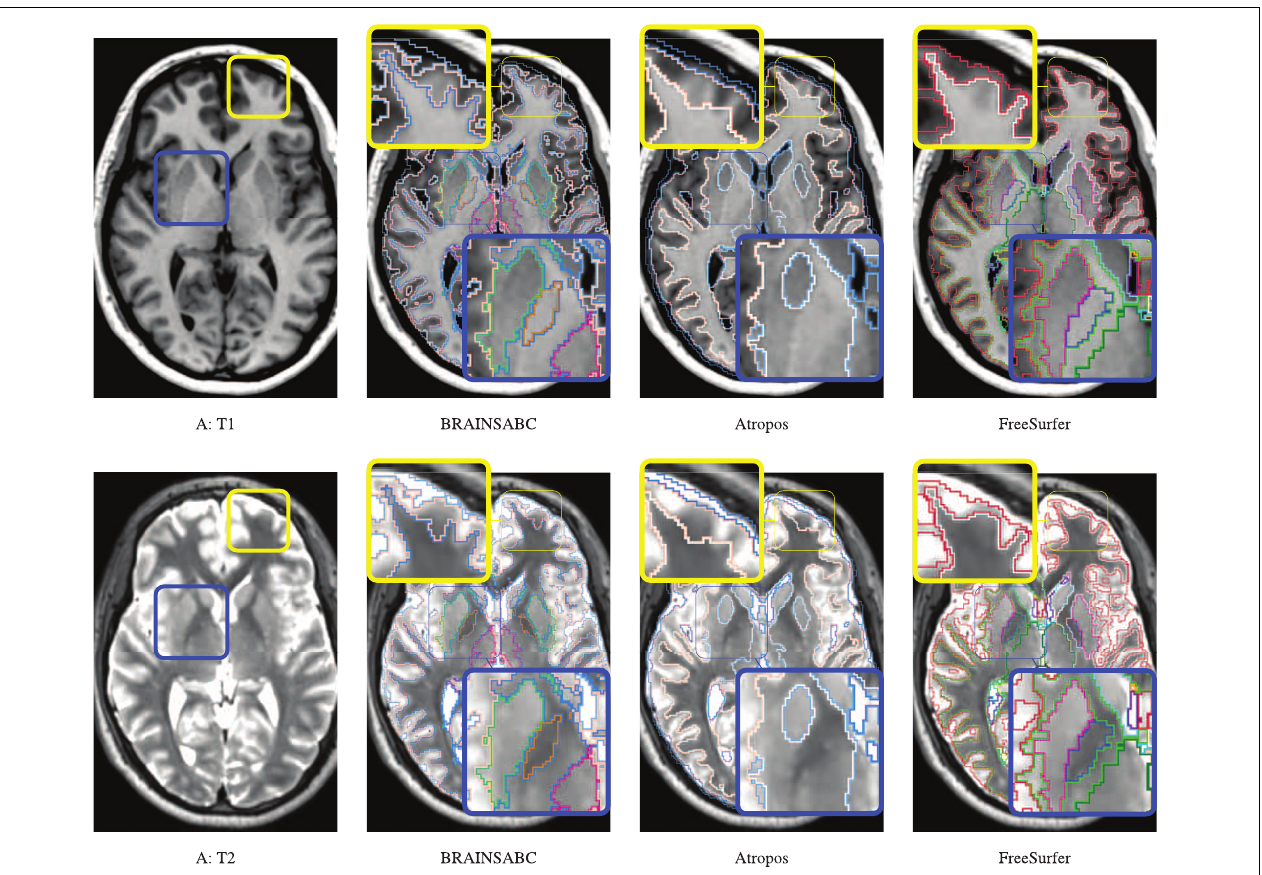
FIGURE 4 | Visual Comparison of Scan A in Table 2. Tissue classification results from three applications, BRAINSABC, Atropos of ANTS Tools, and FreeSurfer on top of T1- and T2-weighted images, multi-modal repeated scan processing. This subject present relatively normal tissue ratio, reflecting minimal, if exists, atrophy in brain tissues. Red and blue boxes highlight where tissue classification is more differentiated from each other.